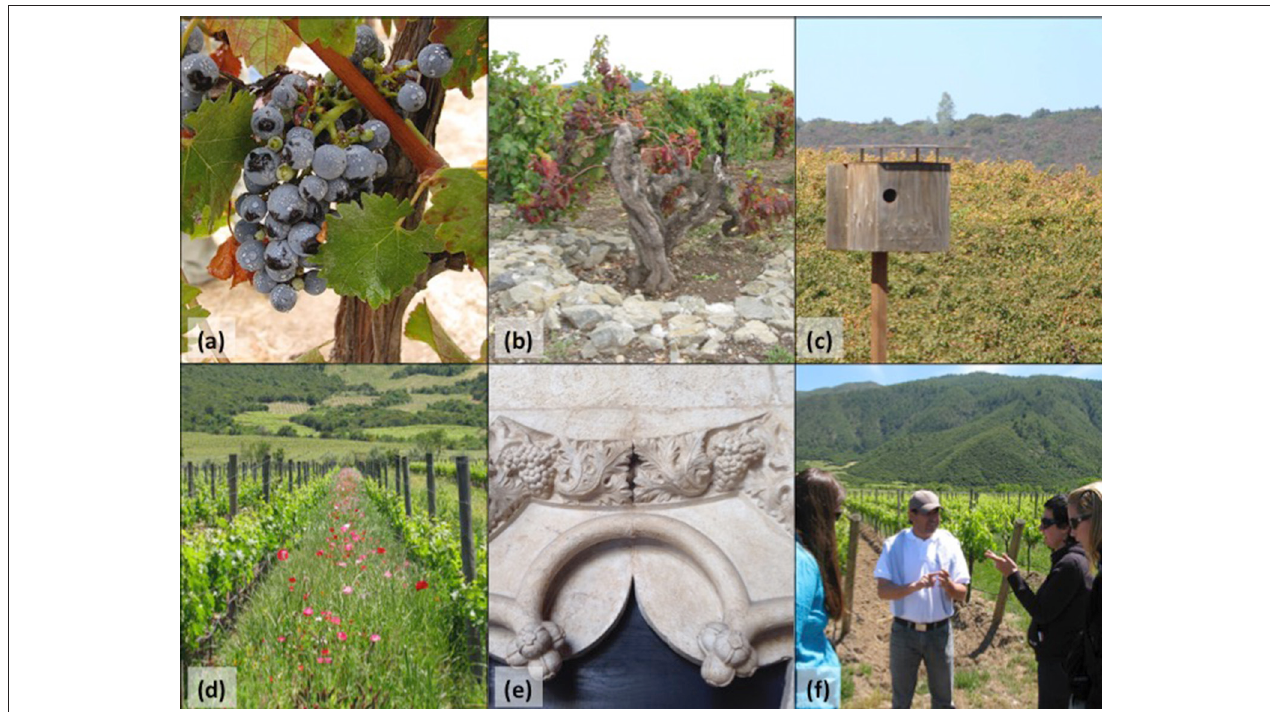
FIGURE 1 | Pictures illustrating the six key ecosystem services we identified in vineyards. Top row (left to right): (a) winegrapes ( cultivated crops) ; (b) vines storing carbon ( sequestration ); (c) owl box for rodent control ( pest control ). Bottom row (d) providing habitat for beneficial insects ( disease control ); (e) grapes motif decorating 500 years old monastery in Portugal ( heritage ); (f) vineyards as research grounds ( scientific ). [pictures: KAN (a) ; JHV (b,c,d,f) ; KJW (e)